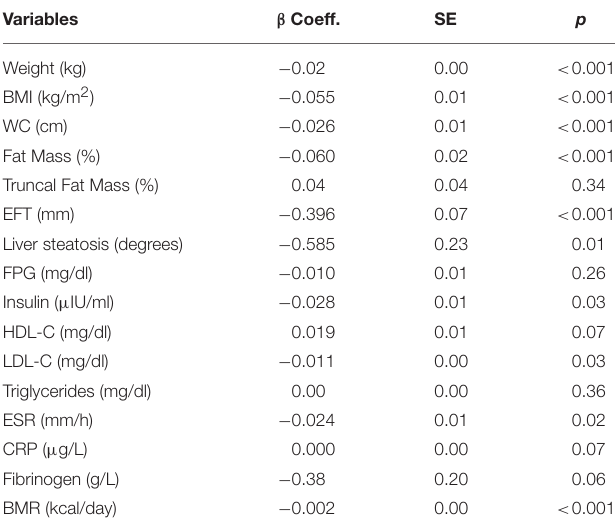
BMI, body mass index; WC, waist circumference; EFT, epicardial fat thickness; FPG, fasting plasma glucose; HDL-C, high-density lipoprotein-cholesterol; LDL-C, low-density lipoprotein-cholesterol; ESR, erythrocyte sedimentation rate; CRP, C-reactive protein; BMR, basal metabolic